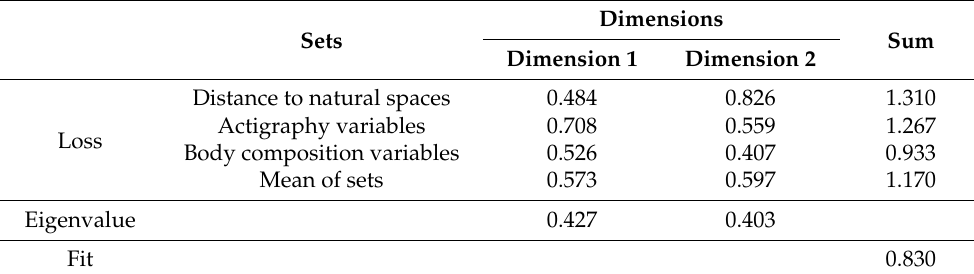
Table 3. Two-dimensional results.